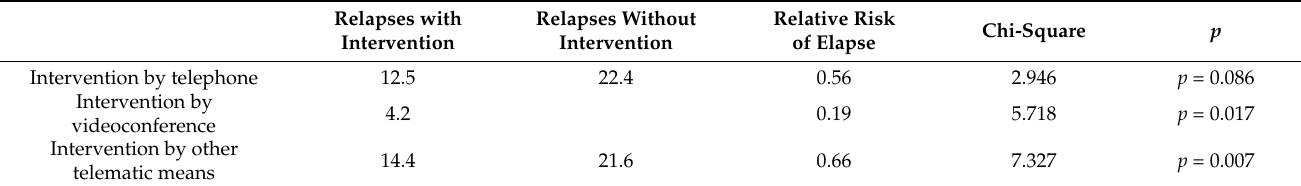
Table 4. Risk of relapse with hospital admission as a function of the different telematics interventions. Relapses with